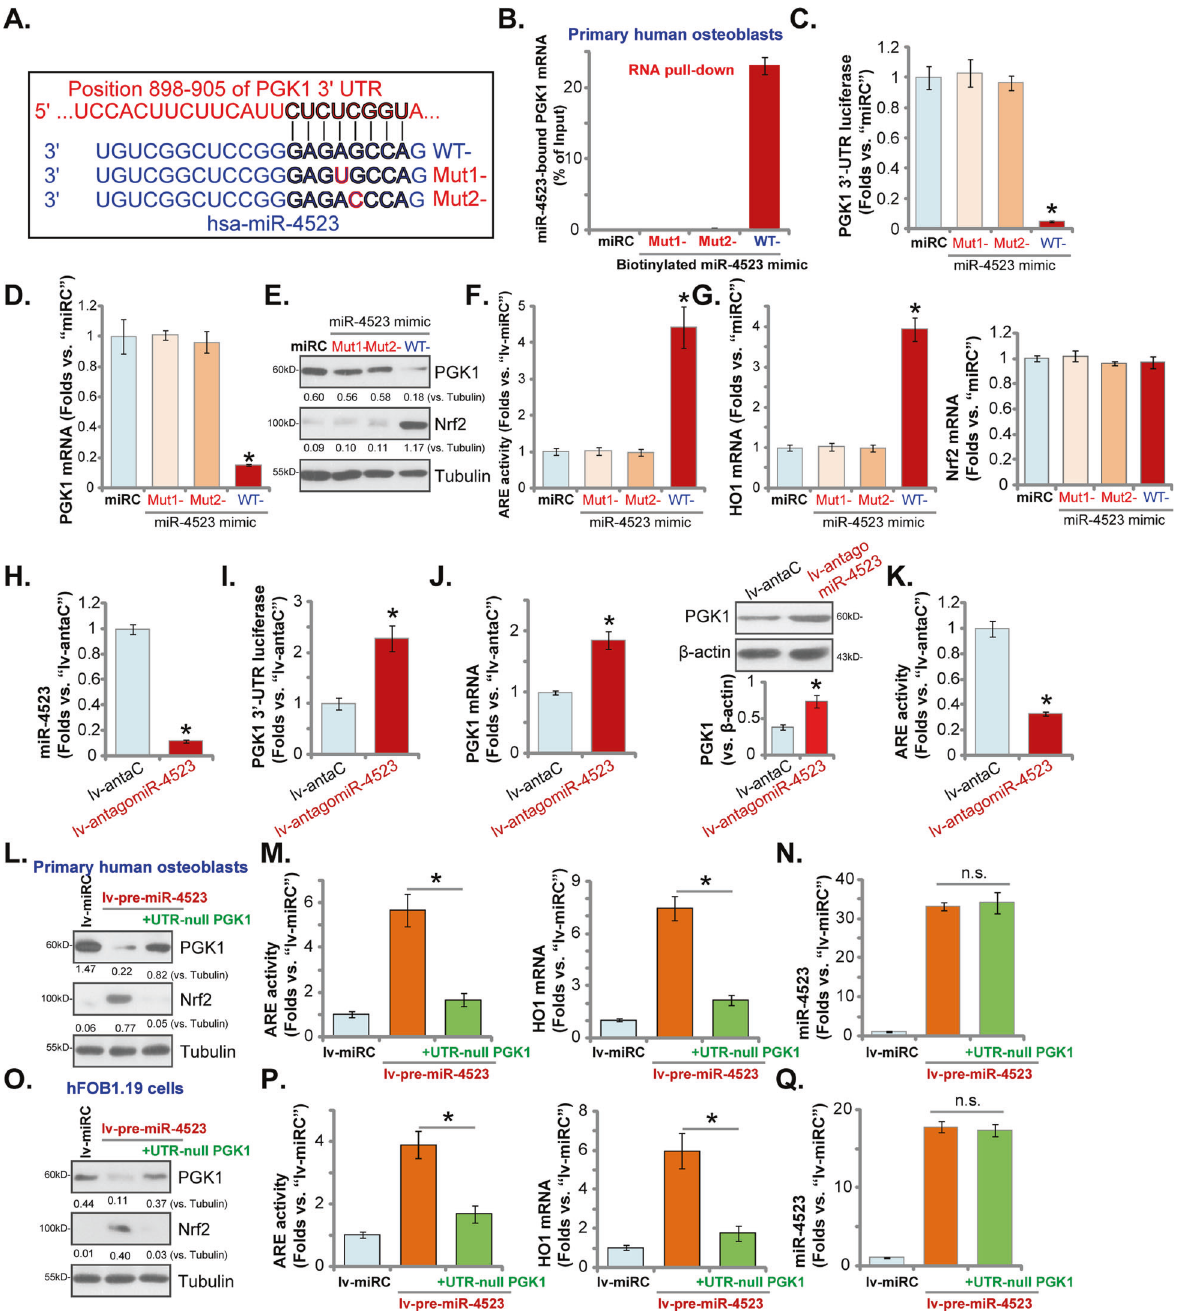
Fig. 2 Nrf2 cascade activation by miR-4523 is due to PGK1 silencing in human osteoblasts. The sequences of the wild-type (WT) and mutant miR-4523 mimics were listed ( A ). RNA pull-down assay results con fi rmed the direct binding between biotinylated-WT-miR-4523 (but not the mutants) and PGK1 mRNA in primary human osteoblasts ( B ). The primary human osteoblasts were transfected with applied WT or mutant miR-4523 mimics (500 nM for 24 h, two rounds), relative PGK1 3 ′ -UTR luciferase activity ( C ), expressions of listed mRNAs ( D and G ) and proteins ( E ) as well as the relative ARE activity ( F ) were tested. Stable human osteoblasts expressing the lentiviral construct encoding the antisense sequence of miR-4523 (lv-antagomiR-4523) or the control construct (lv-antaC) were established and cultured. Expression of miR- 4523 was tested ( H ). The PGK1 3 ′ -UTR luciferase reporter activity ( I ) as well as its mRNA and protein expression ( J ) were tested, with the relative ARE activity ( K ) examined as well. Primary human osteoblasts ( L – N ) or hFOB1.19 osteoblastic cells ( O – Q ), expressing the lentiviral construct encoding the pre-miR-4523 ( “ lv-pre-miR-4523 ” ), were further transduced with or without 3 ′ -UTR-depleted PGK1 construct ( “ + UTR-null PGK1 ” ). Control cells were transduced with the control miR construct (lv-miRC). Expression of listed proteins was tested by western blotting assays ( L and O ). The ARE activities, HO1 mRNA levels ( M and P ), and miR-4523 expression ( N and Q ) were also tested. Data were presented as mean ± standard deviation (SD, n = 5). “ miRC ” stands for non-sense control miRNA mimic ( B – G ) * P < 0.05 versus “ miRC ” cells ( B – G ). * P < 0.05 versus “ lv-antaC ” cells ( H – K ). * P < 0.05 ( M and P ) “ n.s. ” stands for non-statistical difference ( N and Q ). The experiments were repeated fi ve times with similar results